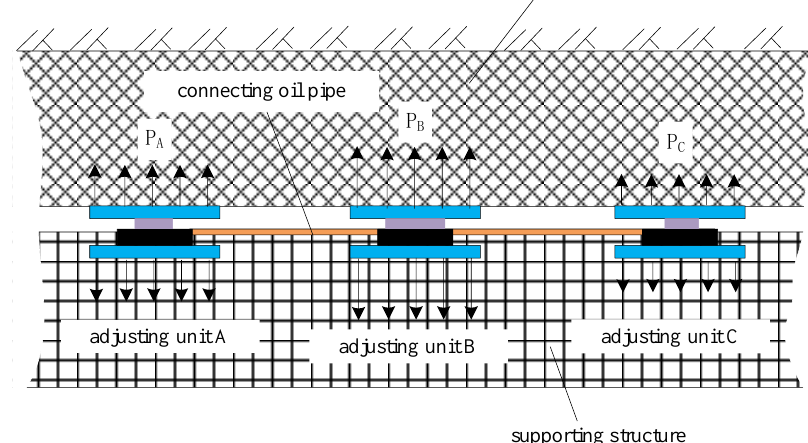
Figure 1. Load transfer and transmission